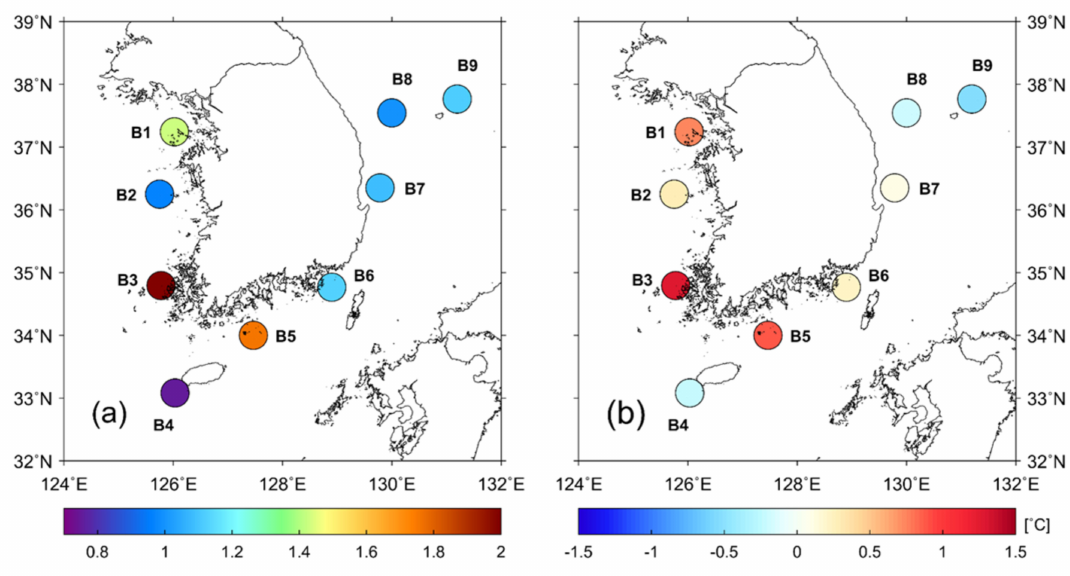
Figure 3. Comparison of satellite SST and in situ KMA buoy SST for each buoy station of KMA, where the color represents ( a ) RMSE and ( b ) bias